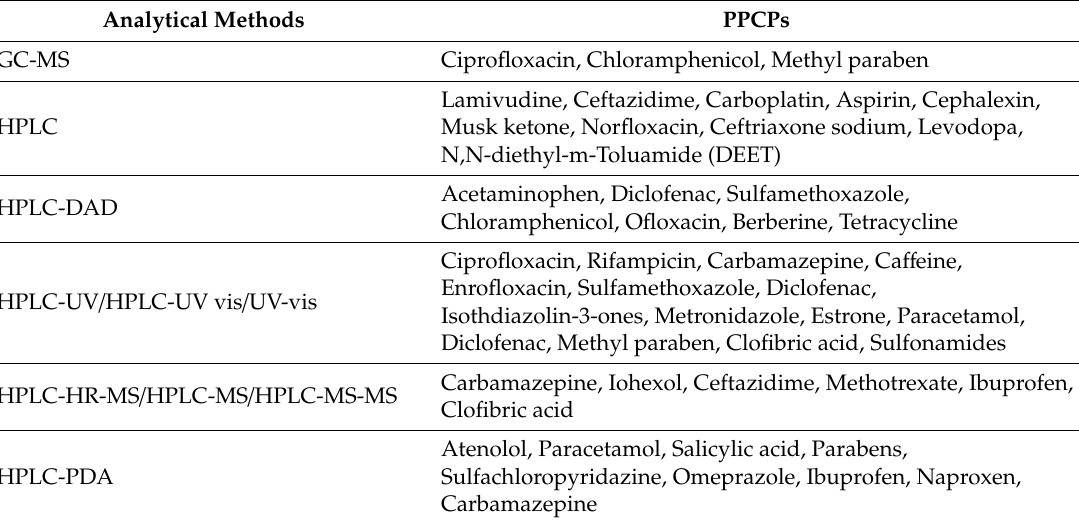
Figure 1. PPCPs analytical method procedure. Solid-phase extraction: SPE; liquid-liquid extraction: LLE; liquid-liquid micro-extraction: LLME; solid-phase micro-extraction: SPME; HPLC: High-performance liquid chromatography; DAD: Diode array detector; PAD: photodiode detector; UV-vis: ultraviolet-visible detector; GC / MS: Gas chromatography–mass spectrometry; LC / MS: Liquid chromatography–mass spectrometry. Table 3. The analytical methods of PPCPs in the literature.